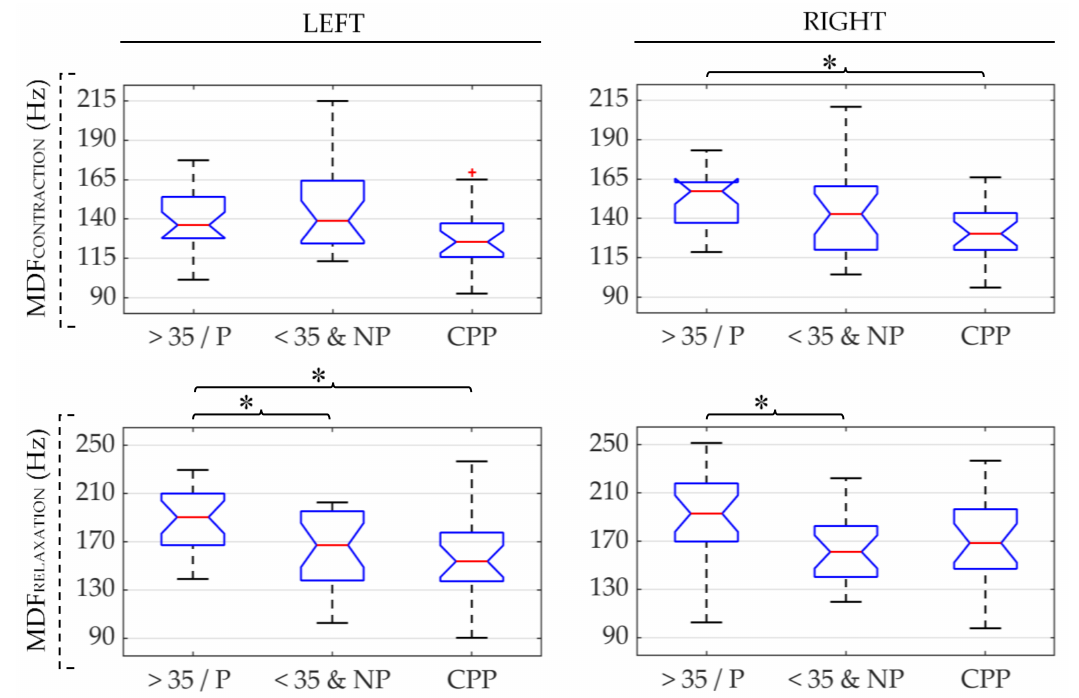
Figure 4. Box-whisker plots of MDF values of the left and right PFM (left and right subfigures, respectively) in patients (CPP), healthy women over 35 and/or parous (>35/P) and healthy women under 35 and nulliparous (<35&NP) during PFM contraction and relaxation (first and second rows, respectively). (*): significant difference between groups under the ends of the brace. Red (+): outlier within the group’s data distribution.